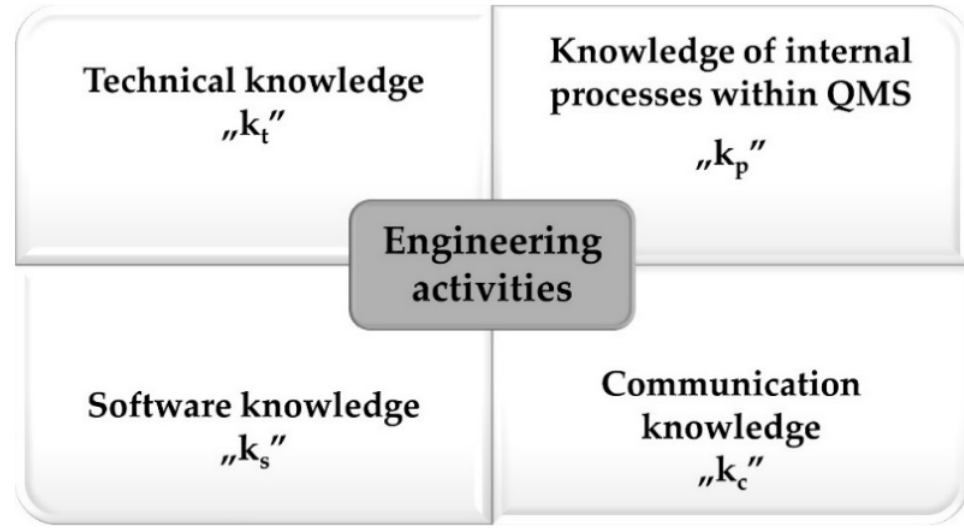
Figure 5. Types of knowledge involved in engineering activities.